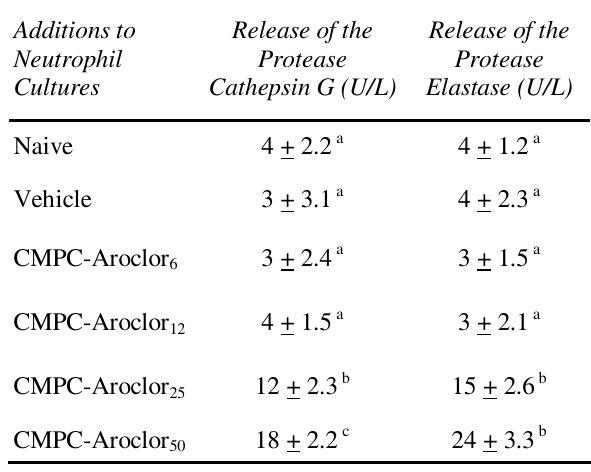
Table 5: Induction of Neutrophil-Derived Protease Release by Conditioned Medium from PC Treated with Aroclor . Isolated neurophils (2 X 10 6 cells/mL) were or vehicle incubated with CMPC-Aroclor (6, 12, 25 or 50 µM) for 24 hrs. After this incubation, culture mediuM as analyzed (spectrophotometry) for the content of = cathepsin G and elastase. CMPC-Aroclor (X) conditioned mediuM from PC treated with Aroclor, where (X) is the concentration of Aroclor; Values represent mean + S.E.M.; a, b, c indicate values that are significantly different (p<0.05).